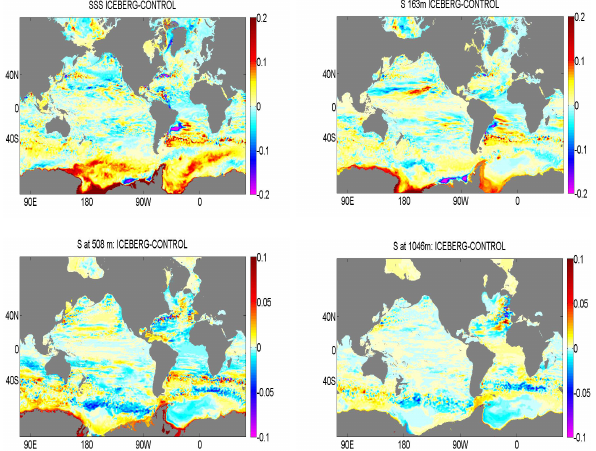
Figure 7. As Fig. 6, for potential